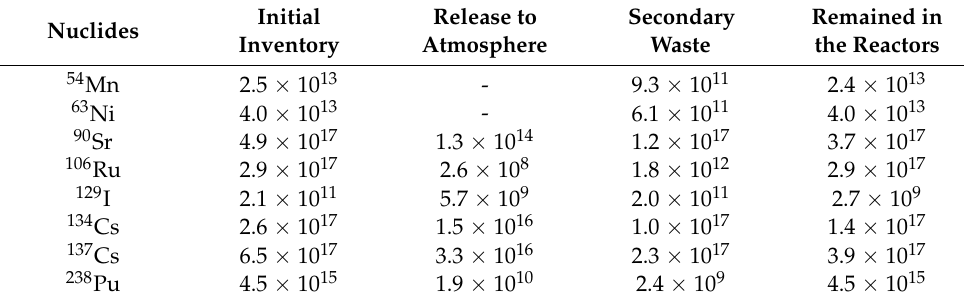
Table 1. Distribution of radionuclide inventory as of 13 March 2014 (unit Bq) [53].